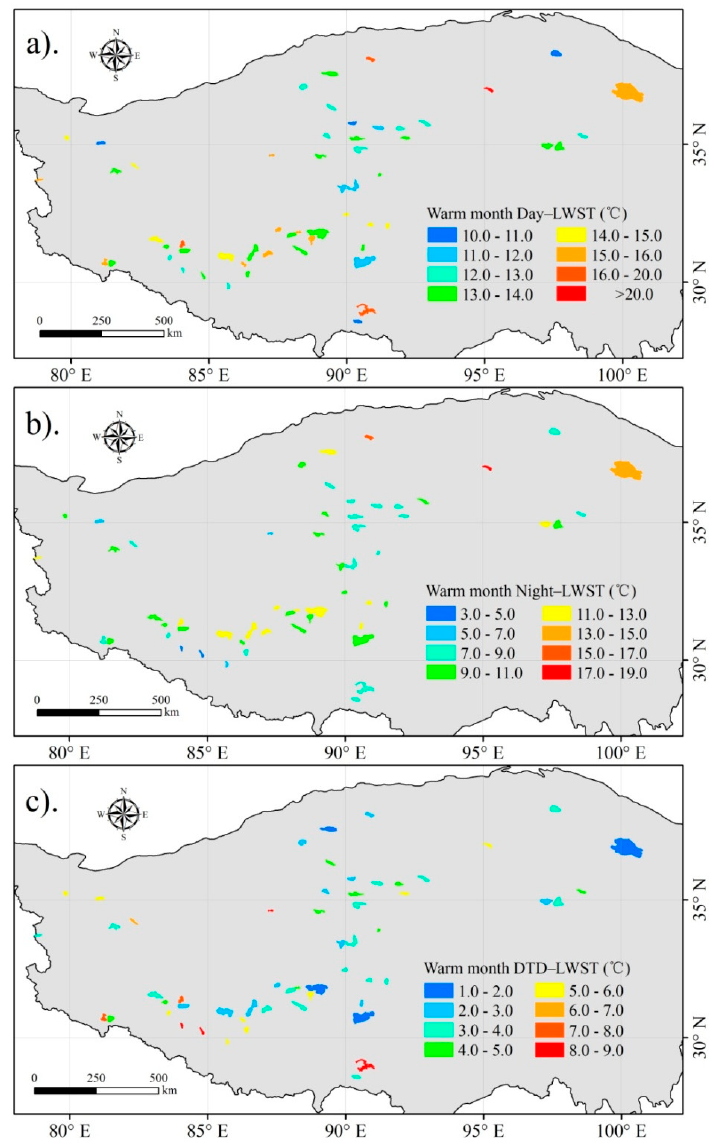
Figure 4. The warm month spatial pattern of water surface temperature for lakes across the Tibetan Plateau: ( a ) daytime LWST variation; ( b ) nighttime LWST variation; and ( c ) lake water surface diurnal temperature difference (DTD).